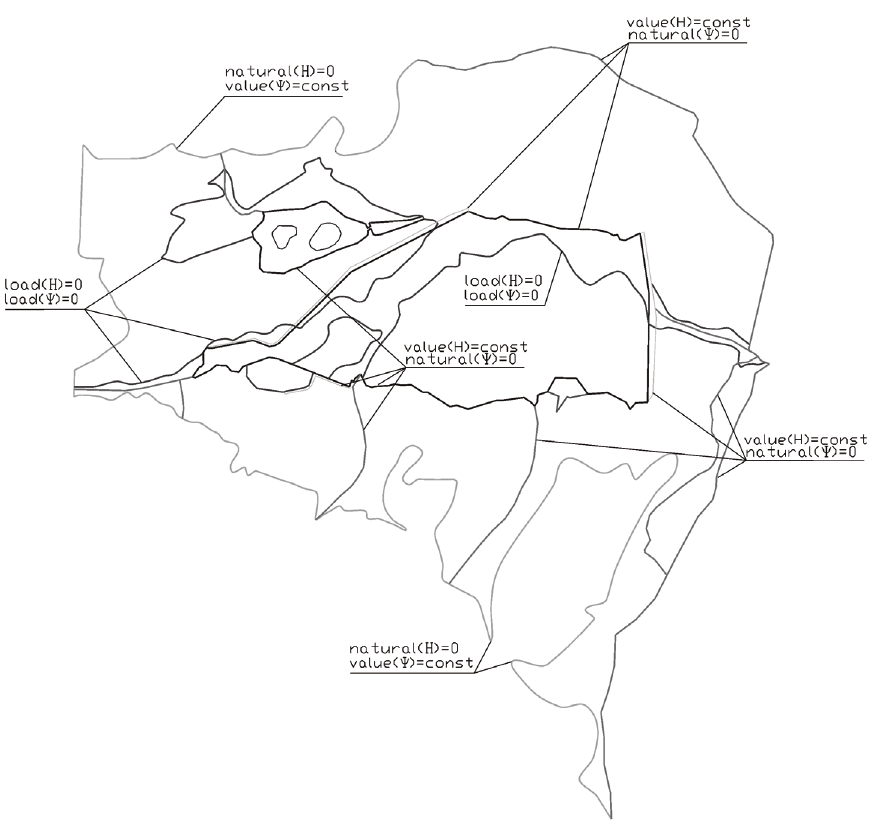
Fig. 7. Boundary conditions of the numerical seepage